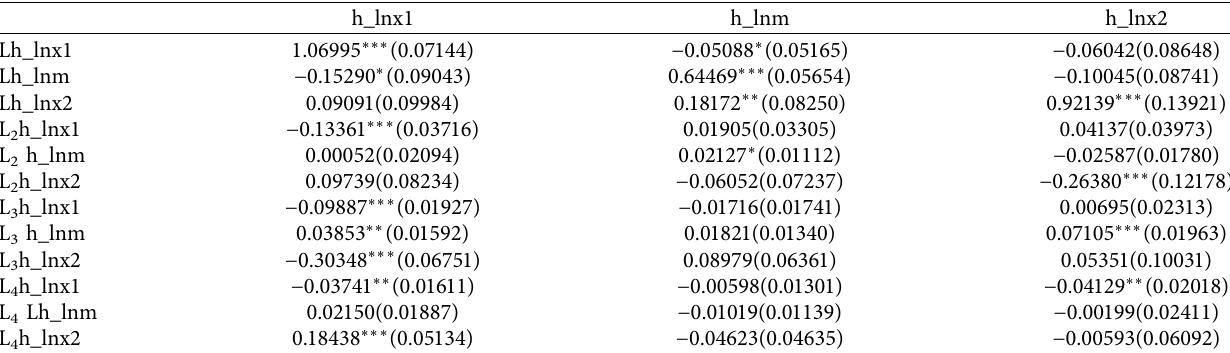
Table 11: Estimated results running system